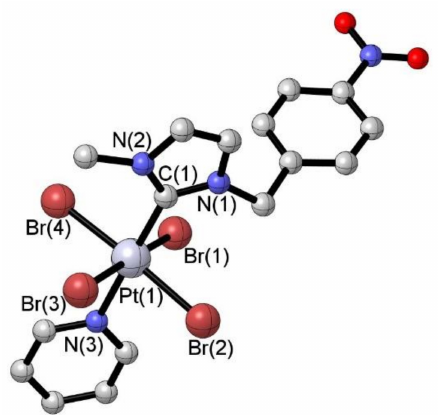
Figure 1. Molecular structure of complex 15 . Selected bond distances (Å) and angles (deg): C(1)-Pt(1), 2.057(8); Br(1)-Pt(1), 2.4882(8); Br(2)-Pt(1), 2.4657(8); Br(3)-Pt(1), 2.4615(8); Br(4)-Pt, 2.4839(8); N(3)-Pt(1), 2.128(6); C(1)-Pt(1)-N(3), 179.2(3); C(1)-Pt(1)-Br(3), 92.9(2); N(3)-Pt(1)-Br(3), 87.10(16); Br(2)-Pt(1)-Br(3), 86.10(3); Br(1)-Pt(1)-Br(4),